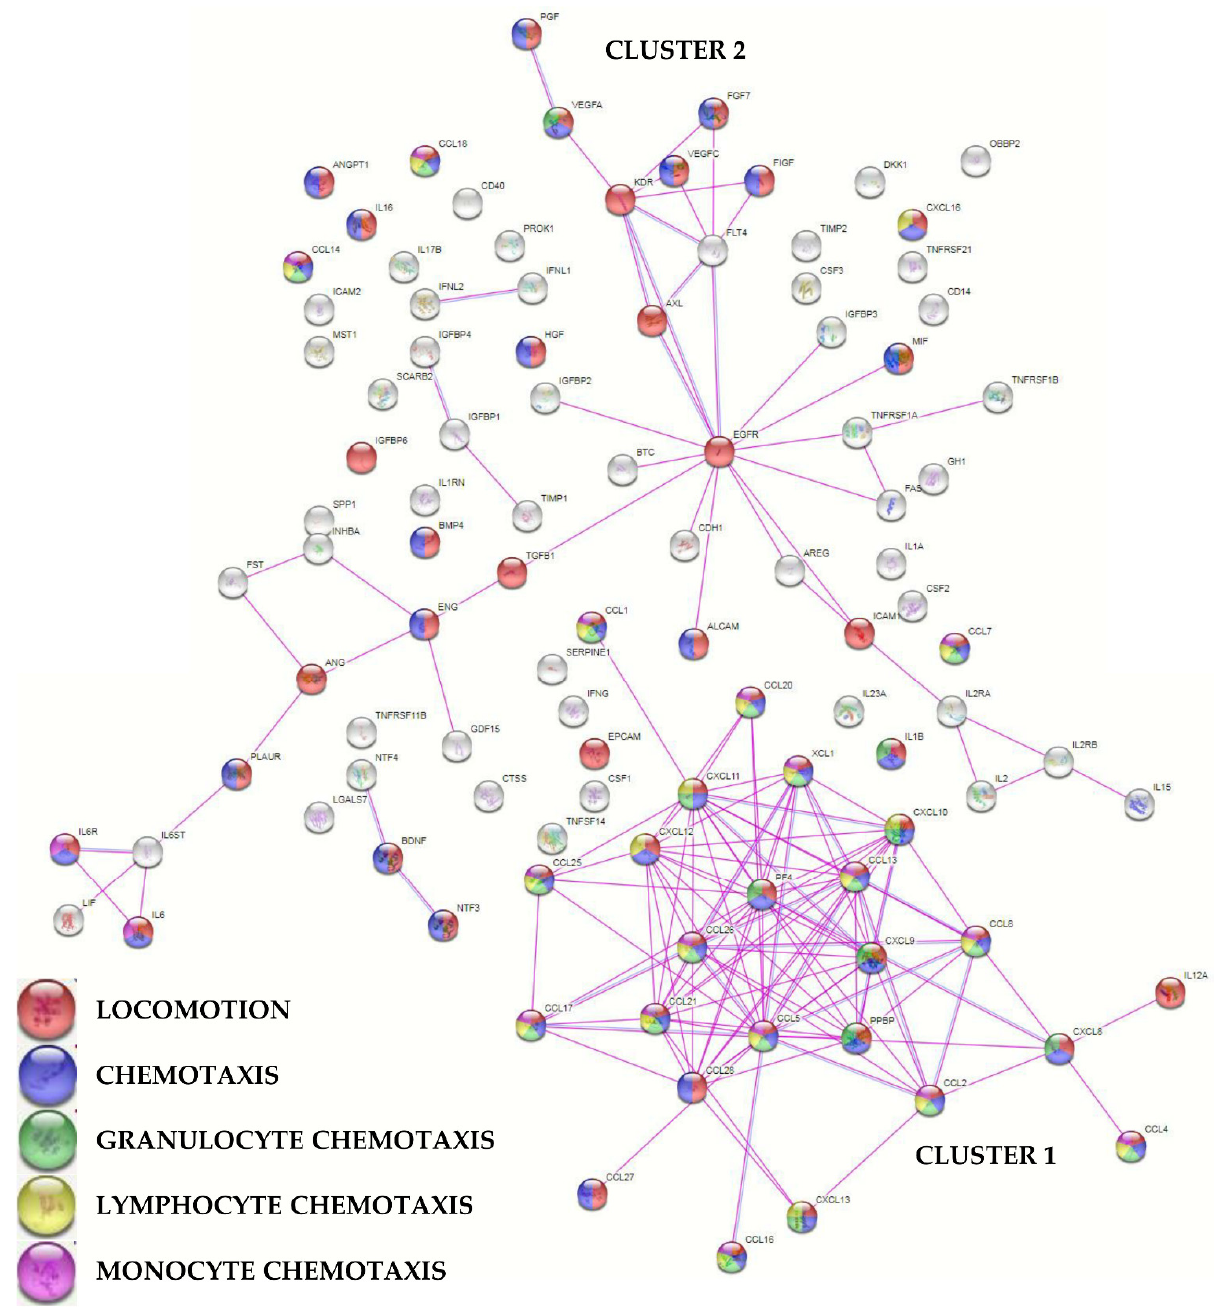
Figure 3. Functional association network for identified PRP-treated BMSCs’ secreted factors. Violet connections are for proteins with experimentally determined interactions; blue connections are for proteins with known interactions based on curated databases. Empty nodes, proteins of unknown 3D structure; filled nodes, known or predicted 3D structure. Locomotion, chemotaxis (with distinction in granulocyte, lymphocyte, and monocyte) GO terms are shown.